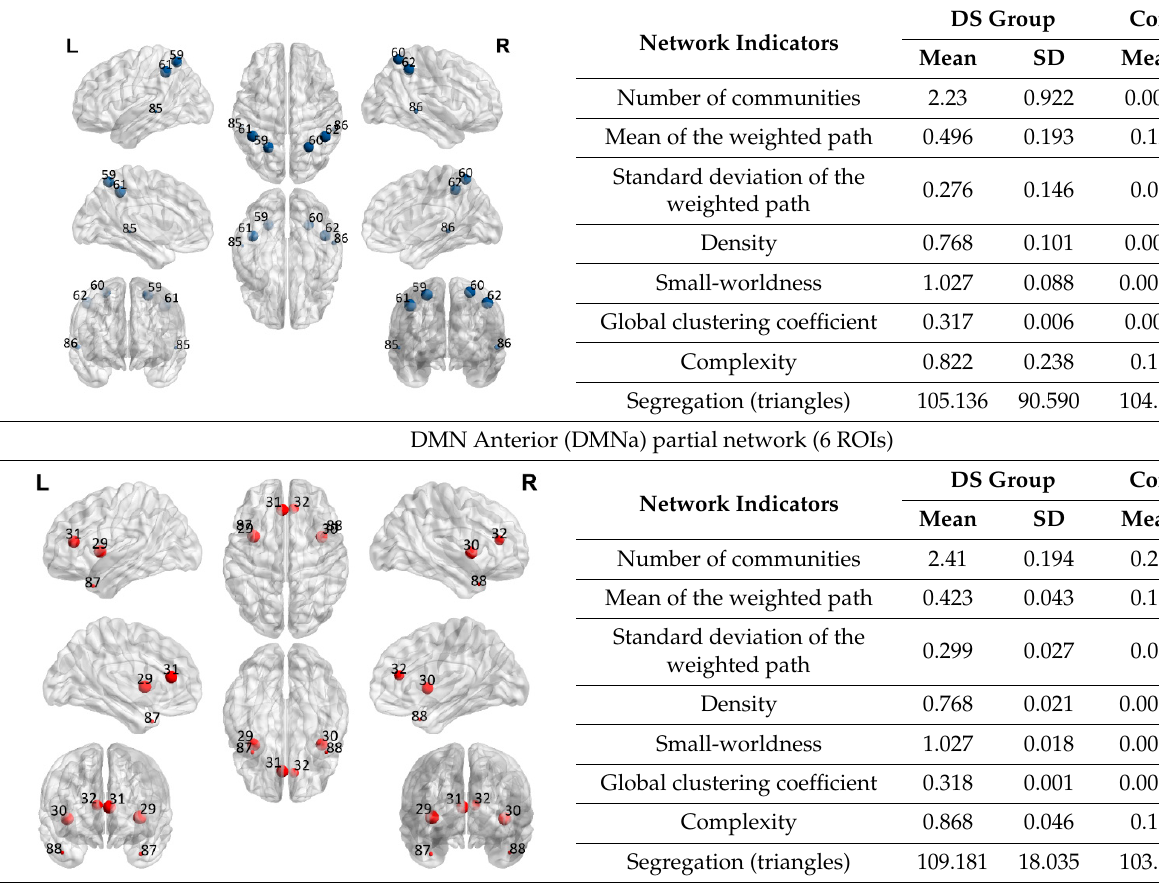
Table 4. Descriptions of the observed distributions of the complexity indicators in each group in the five subnetworks and the entire network that make up the DMN and their distribution according to the AAL atlas. The number of ROIs coincides with the description in Table 1. SD: standard deviation. DMN partial network (6 ROIs). DMN partial network (6 ROIs).